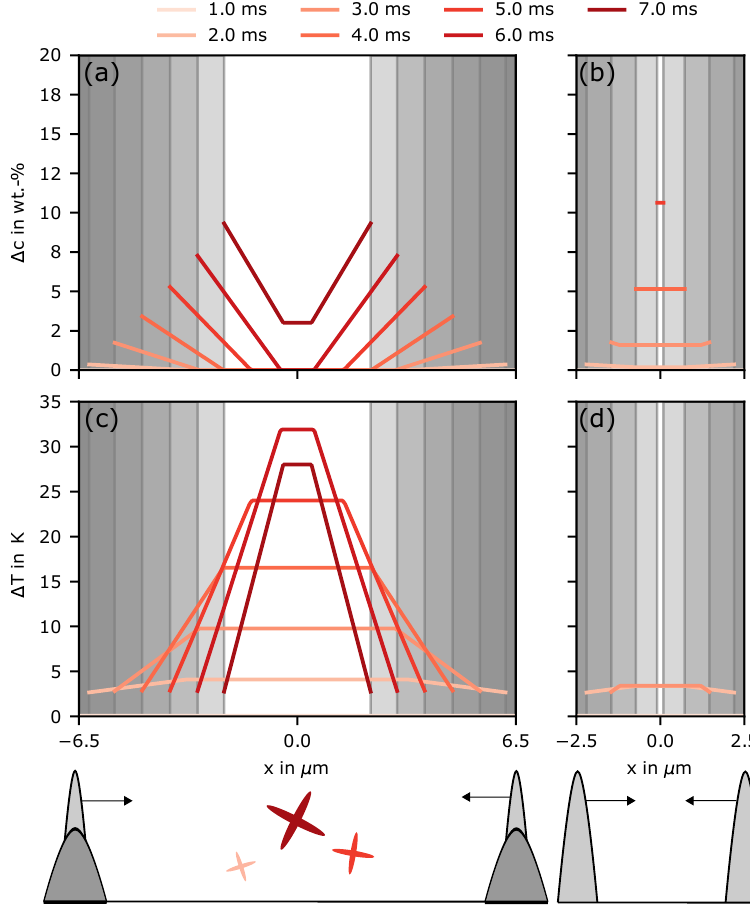
Figure 6. Concentration variation ∆ c = c l − c 0 in the interdentritic space over several times for ( a ) coarse ( λ = 13µm) and ( b ) fine ( λ = 5µm) dendrites under the same solidification conditions obtained by simulation. ( c , d ) The corresponding undercooling ∆ T evolution based on the local concentration/liquidus temperature and the local temperature evolution at the deepest melted point marked in Figure A2. The schematic at the bottom illustrates the condition of dendrites growing on a remelted structure with a bigger dendrite arm spacing (left) and dendrites growing with the equilibrium spacing for the same solidification conditions